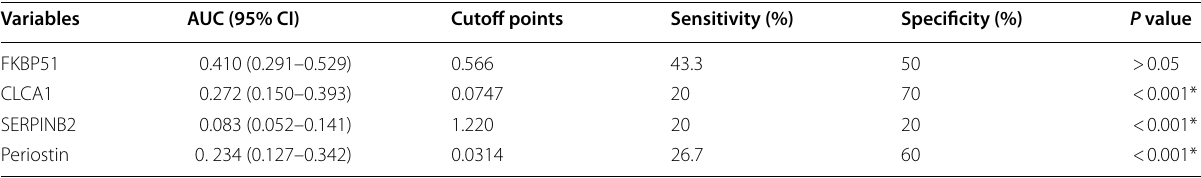
Table 5 Performance characteristics of FKBP51, CLCA1, SERPINB2 and periostin expression (2 − ∆Ct ) to detect asthma